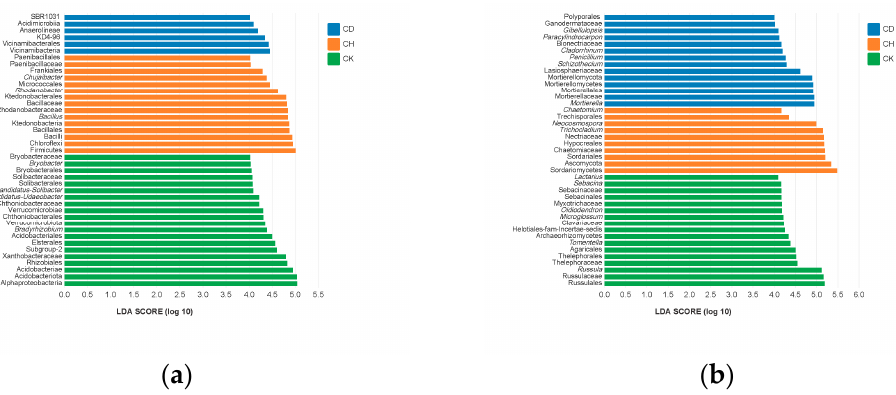
Figure 13. LDA scores of the differentially abundant taxa. ( a ) Taxa enriched in bacterial microbiota from CK, CH, or CD are indicated with LDA scores (taxa with relative abundances >0.001 and LDA scores >4 are shown). ( b ) Taxa enriched in fungal microbiota from CK, CH, or CD are indicated with LDA scores (taxa with relative abundances >0.001 and LDA scores >4 are shown). CH—biennial